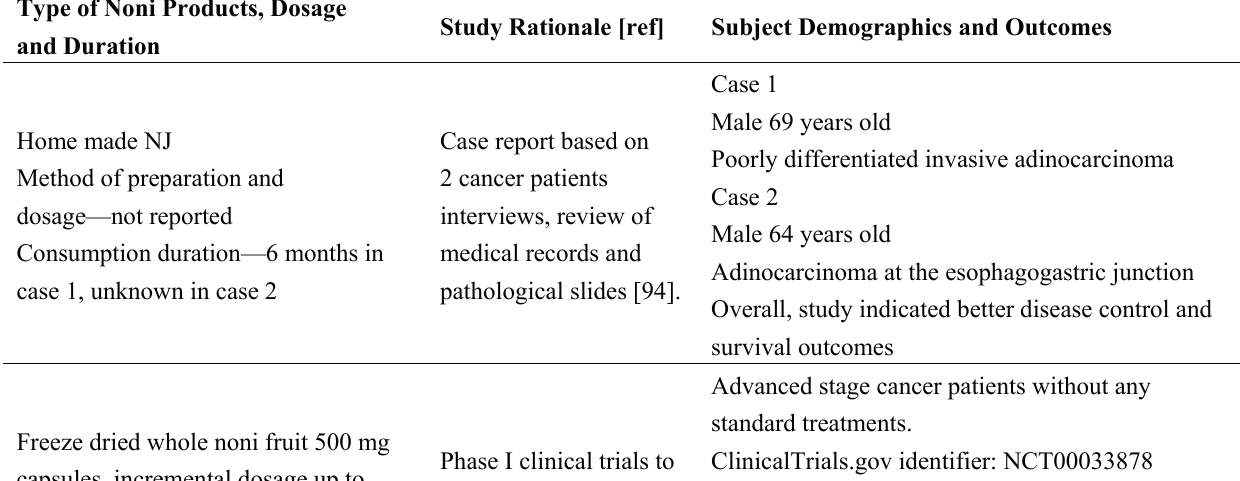
Table 4. Clinical studies demonstrating safety and health benefits of